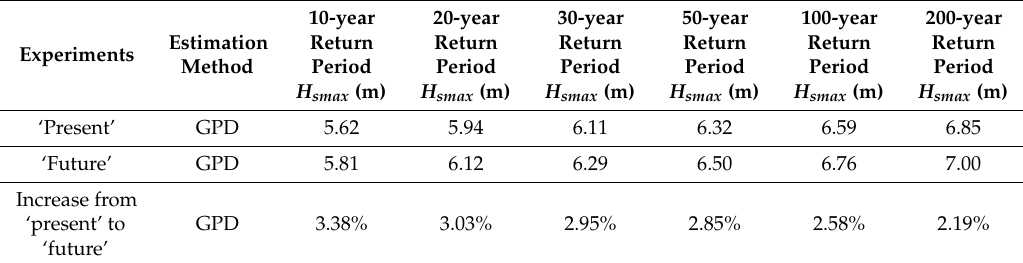
Table 1. Estimated statistically significant peak storm wave heights ( H smax ) with different return periods based on the GPD distributions.